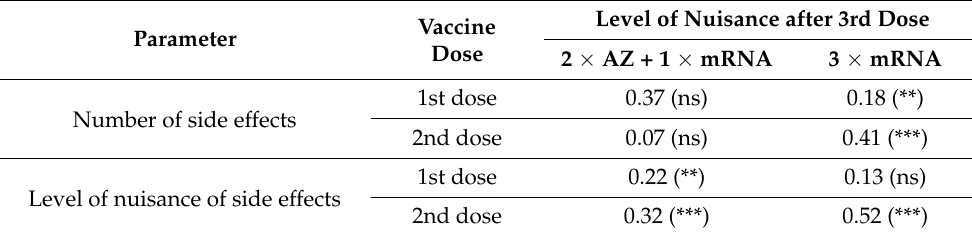
Table 3. The Spearman’s correlation coefficient calculated between a number of side effects and nuisance level primary vaccine doses and nuisance level of side effects after the third dose in the homogenously and heterologously boosted groups.